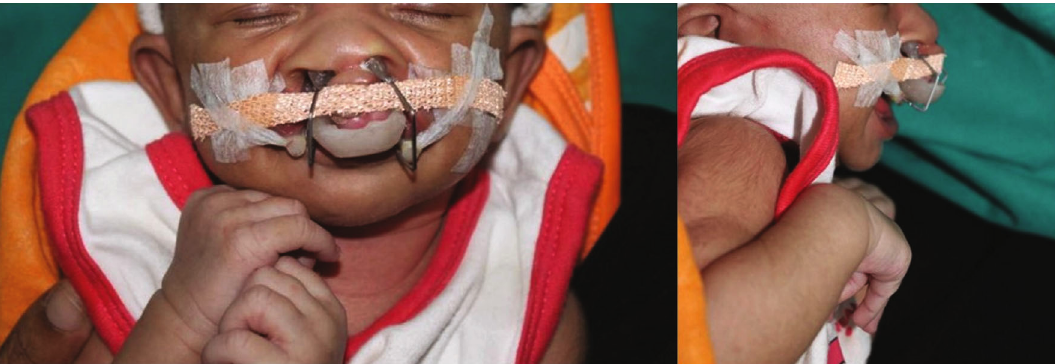
Figure 3: Insertion of a 3D Versascrew appliance.